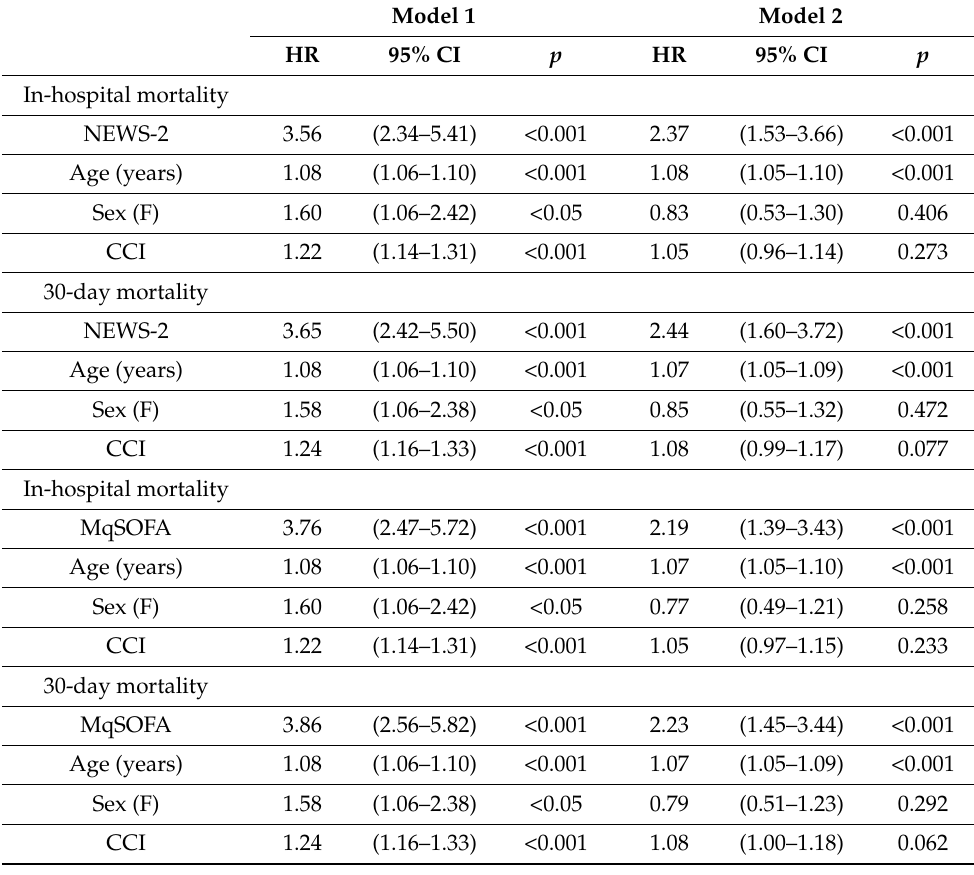
Table 4. Multivariate logistic regression analysis for the probability of in-hospital and 30-day mortality (NEWS-2 vs. MqSOFA).